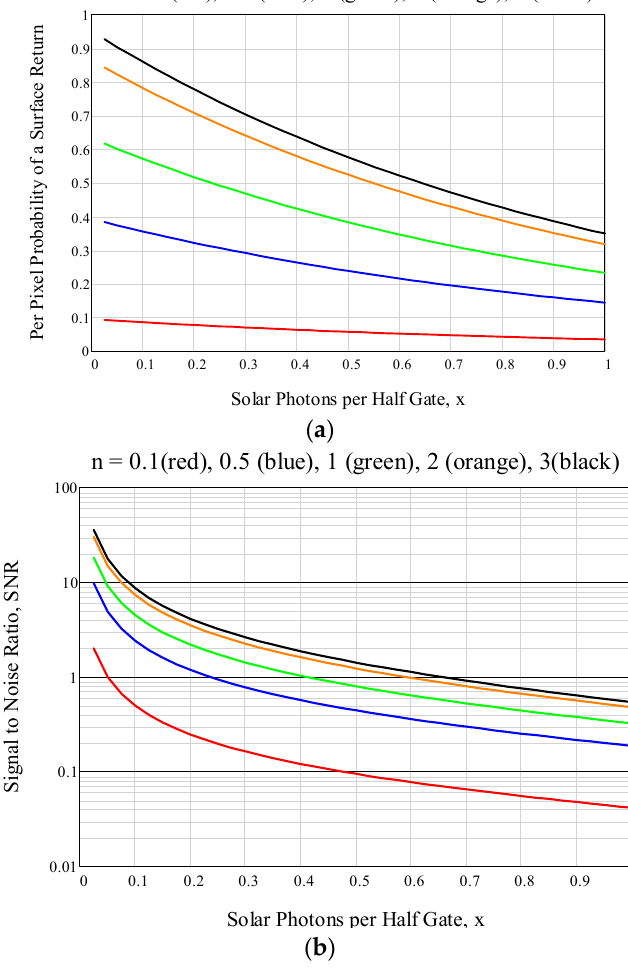
Figure 15. ( a ) Fraction of pixels recording surface returns as a function of surface signal strength, n , and mean number of noise photons detected within a half range gate; ( b ) ratio of signal to noise counts as a function of the same two parameters.